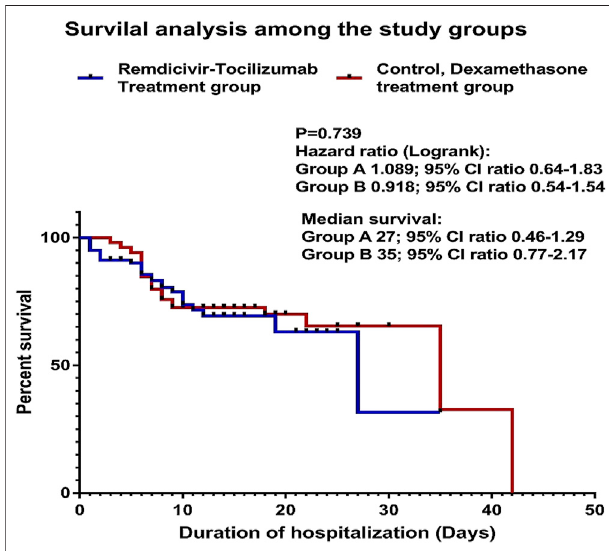
FIGURE 2 | Kaplan – Meier survival analysis among the study